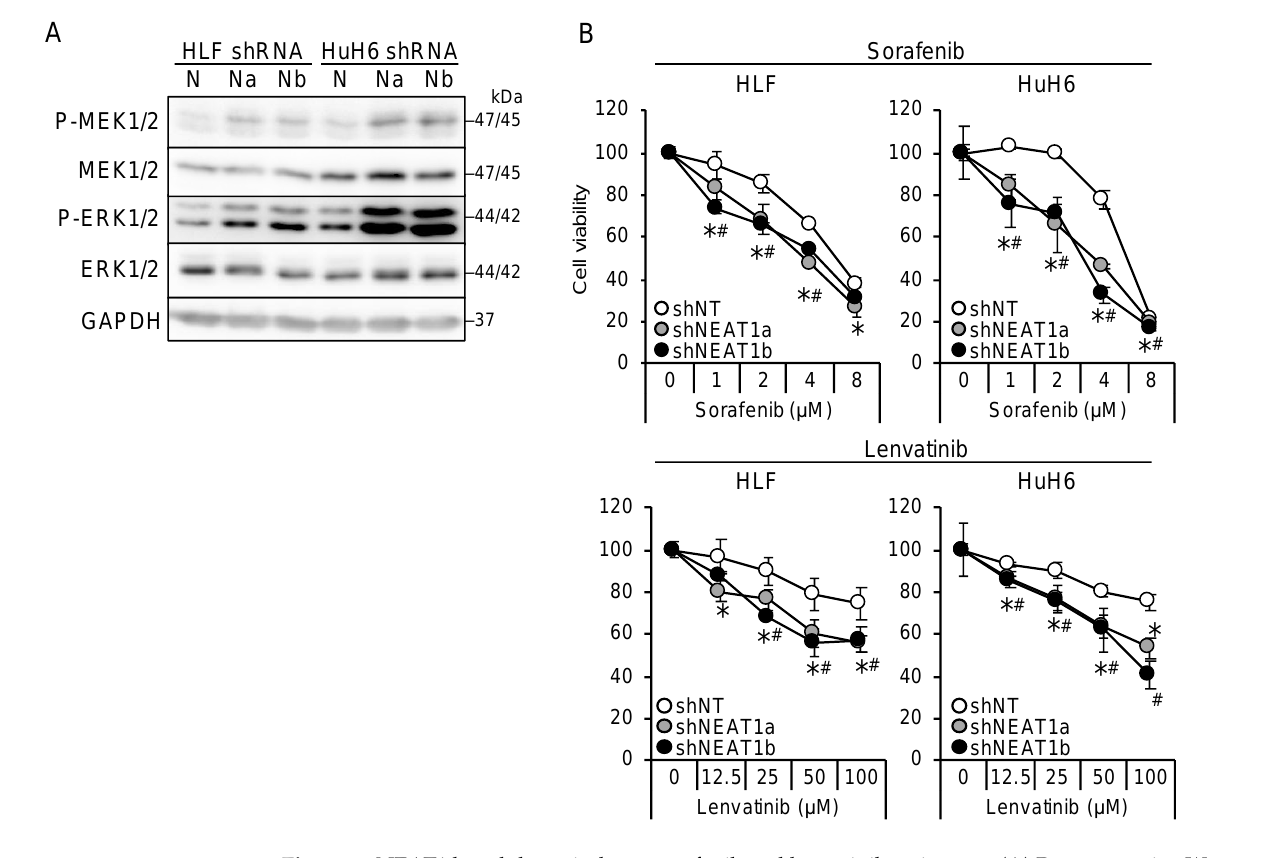
Figure 1. NEAT1 knockdown induces sorafenib and lenvatinib resistance. ( A ) Representative Western blot images for the indicated proteins. GAPDH is shown as an internal control. HLF and HuH6 cell lines were transduced with adenoviruses expressing nontargeting shRNA [shNT (N)] or NEAT1-specific shRNAs [shNEAT1a (Na) and shNEAT1b (Nb)] for 48 h. ( B ) Viabilities of HLF and HuH6 cells treated with sorafenib or lenvatinib at the concentrations indicated in the figure for 48 h relative to cells treated with dimethyl sulfoxide (DMSO; 100%). Cells were transduced with adenoviruses expressing shNT, shNEAT1a, and shNEAT1b 48 h before drug treatment. * p < 0.05 vs. shNT vs. shNEAT1a; # p < 0.05 shNT vs. shNEAT1b (Dunnett’s test; n = 4).